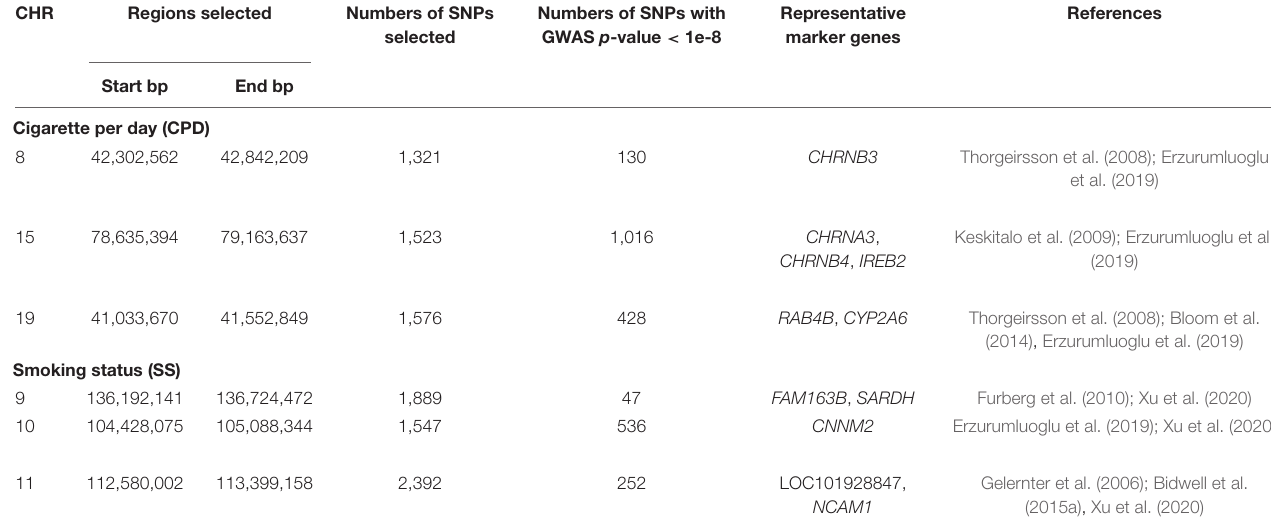
TABLE 1 | The selected genomic regions for causal pathway analysis and representative marker genes. CHR Regions